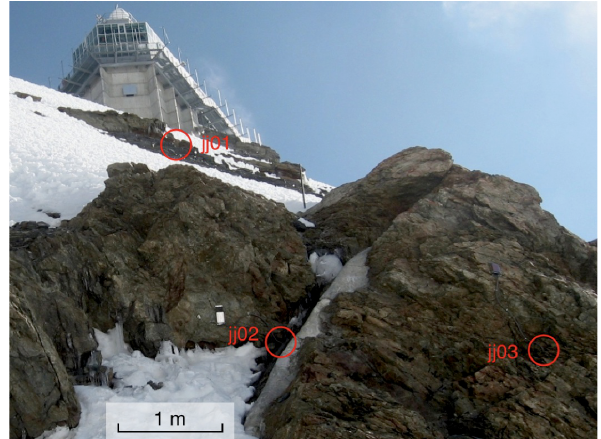
Fig. 2. Overview of the Matterhorn field site at H¨ornligrat. The circles with labels indicate the sensor locations. Note the thin snow cover in the Matterhorn east face (left picture taken in November 2009).